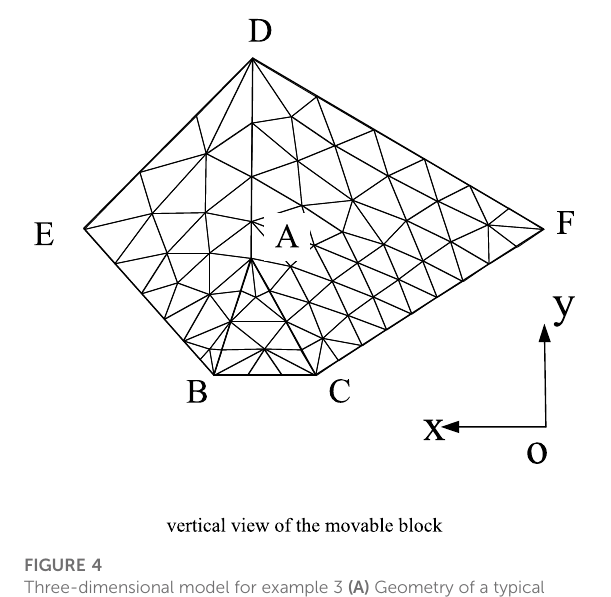
FIGURE 4 Three-dimensional model for example 3 (A) Geometry of a typical moveable block forming by three discontinuities. (B) Vertical view of the movable block.